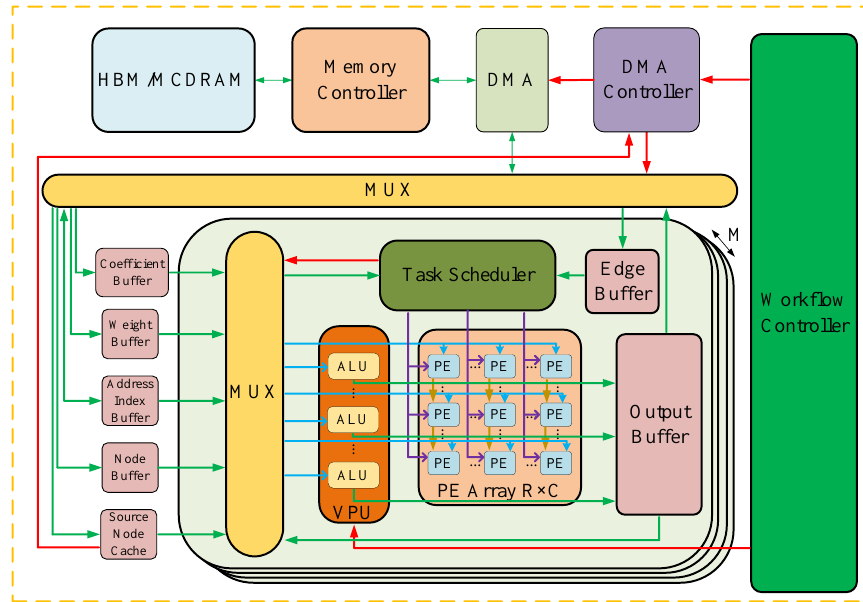
Figure 19. The Adaptive GNN accelerator (AGA) framework.